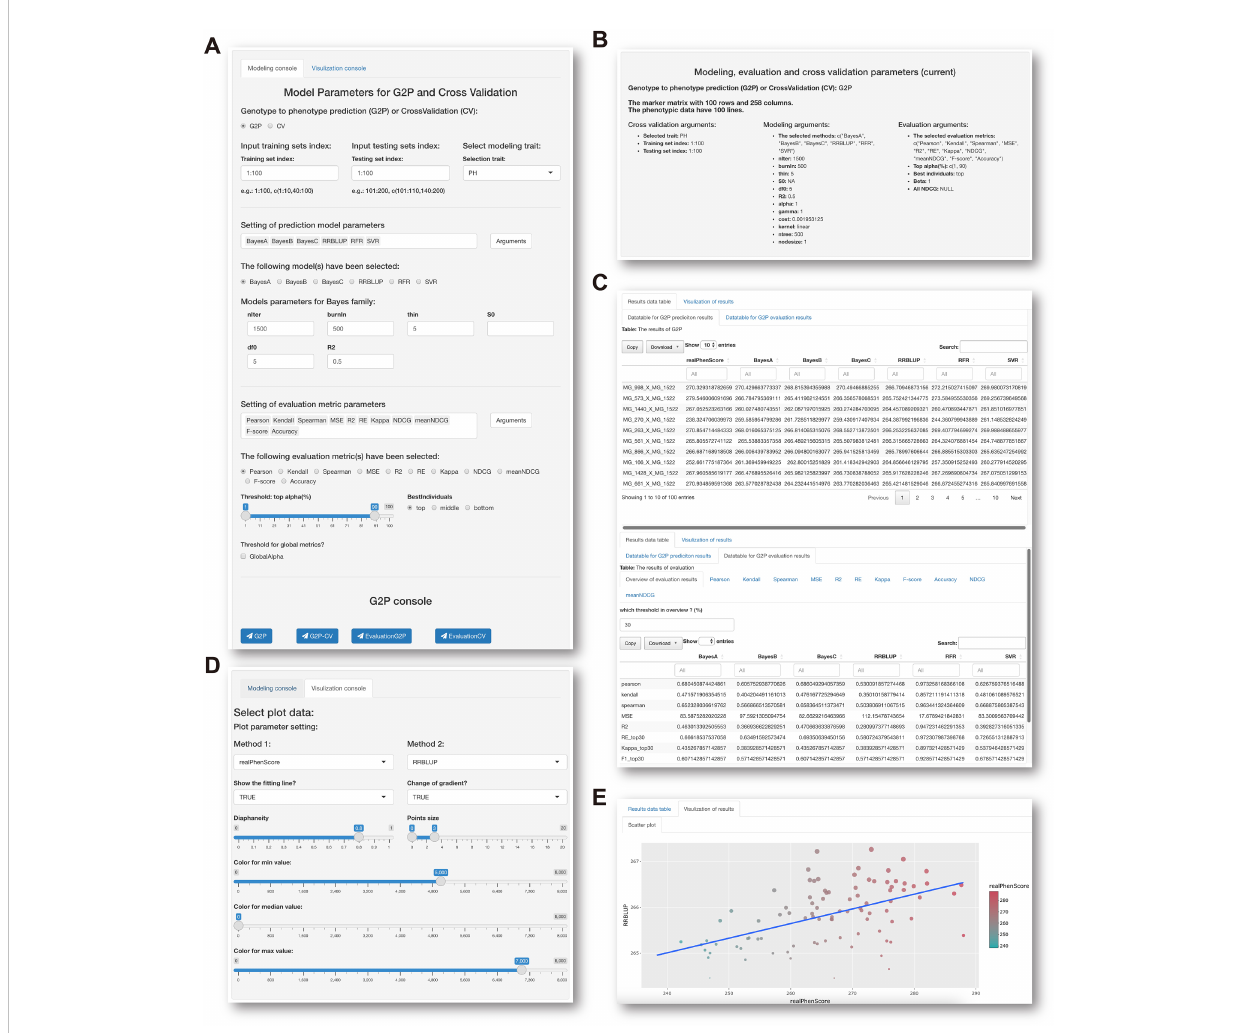
FIGURE 4 GS analysis panel. (A) Modeling console for selection of GS methods, evaluation metrics, and setting of model parameters. (B) Display window for viewing selected models and parameter settings. (C) Previews of prediction results from multiple GS methods (upper panel) and evaluation results from different metrics (bottom panel). (D) Visualization console for viewing prediction results. (E) Display window for viewing scatter plots of observed and predicted